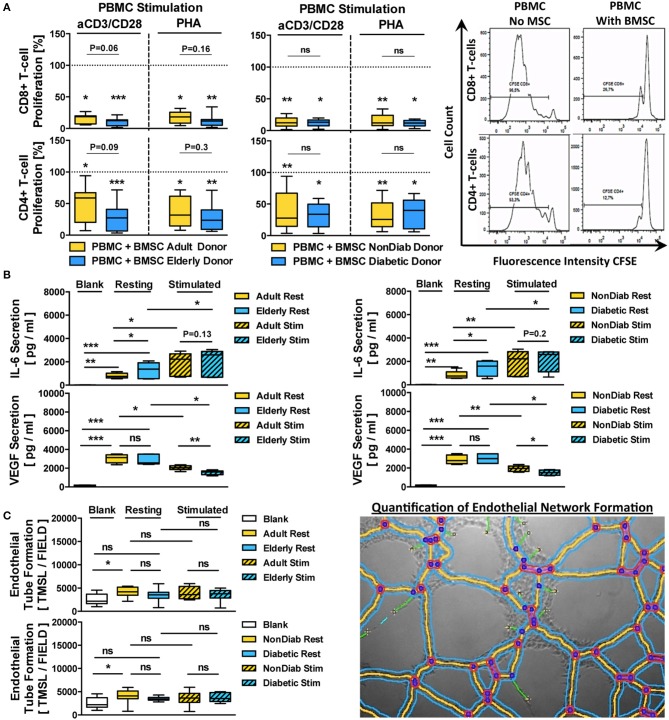
Immunomodulatory and paracrine activity of BMSCs. (A) Immunomodulatory activity of BMSCs (n = 9 adult vs. n = 12 elderly and n = 14 non-diabetic vs. n = 7 diabetic donors, passage 3) to suppress anti-CD3/CD28- or phytohemagglutinin (PHA)-stimulated peripheral blood mononuclear cell (PBMC)-proliferation. The PBMCs were labeled with the cell proliferation-tracker dye CFSE, activated with either of the two different stimuli, and cocultured for 5 days with BMSCs from adult or elderly donors, in order to assess their capacity to inhibit the proliferation of CD4+ and CD8+ T-cells with flow cytometry, with representative histograms shown to the right. The quantitative assessment of T-cell proliferation is expressed as the percentage proliferation of CD4+ and CD8+ T cells relative to the positive control without BMSCs. Both adult vs. elderly and non-diabetic vs. diabetic donor-derived MSCs are equally potent in inhibiting CD4 and CD8 T-cell proliferation. (B,C) Paracrine and proangiogenic activity of BMSCs (n = 9 adult vs. n = 12 elderly and n = 14 non-diabetic vs. n = 7 diabetic donors) with and without cytokine stimulation (10 ng/mL of TNF-alpha and IFN-gamma for 24 h): (B) secretion of IL-6 and VEGF (pg/mL) in BMSC-conditioned culture media was assessed with ELISA, detecting elevated levels of IL-6 secretion by BMSCs obtained from elderly or diabetic donors, and (C) proangiogenic activity of BMSC-conditioned media compared to blank group (medium only) in an endothelial tube formation assay, with a representative image for the quantification of endothelial network formation by quantification of the total master segment length (TMSL/field, with 3–5 images assessed per test condition); TMSL/field was slightly increased for adult and non-diabetic donors. Results are given as box plot ± min-max whiskers. Statistical analysis was performed using either a Student's t-test or ANOVA followed by post-tests (*p < 0.05, **p < 0.01, and ***p < 0.001).